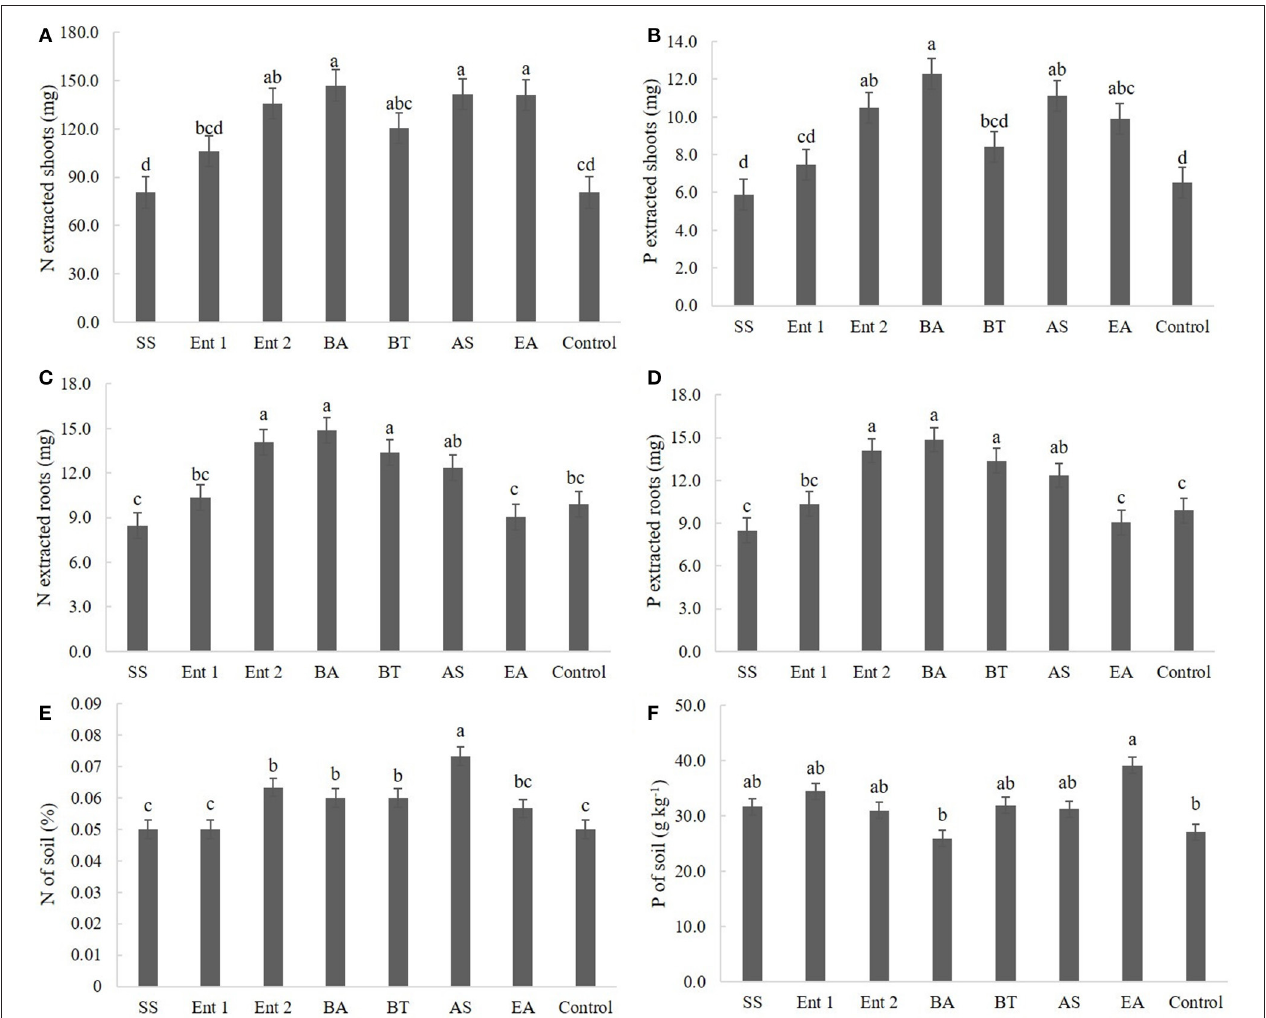
FIGURE 5 | (A) N and (B) P extracted by shoots; (C) N and (D) P extracted by roots; and (E) N and (F) P concentrations in the soil. SS, S. saprophyticus IJ8; Ent 1, Enterobacter sp. IP11; Ent 2, Enterobacter sp. IP14; BA, B. anthracis IP17; BT, B. thuringiensis IP21; AS, A. spanius IP23; EA, E. asburiae IP24; Control, no